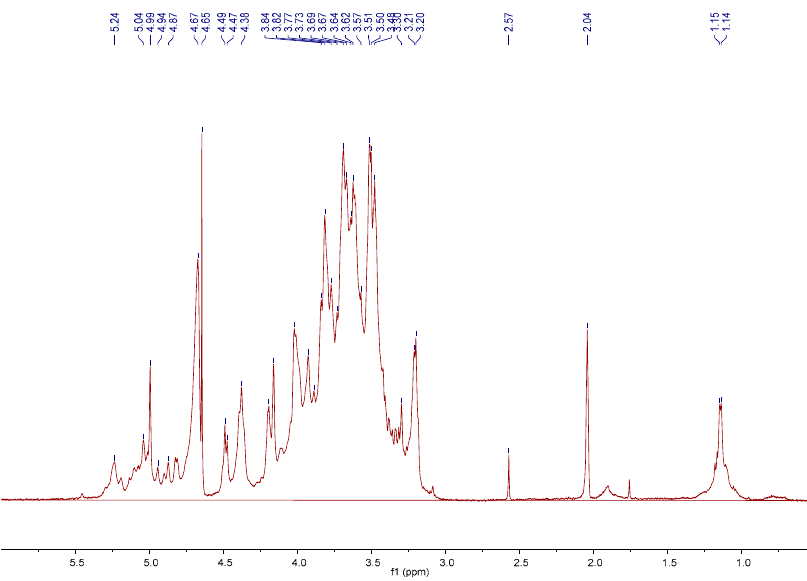
Figure 3. NMR spectrum of the polysaccharides from Athyrium multidentatum (Doll.) Ching.